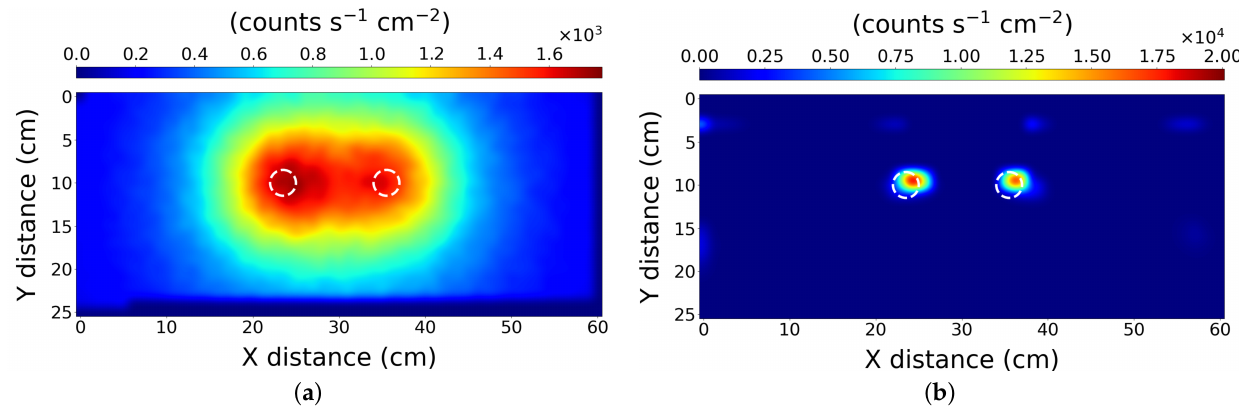
Figure 5. The results from scenario 3—Proximity limit. After processing with ( a ) simple interpolation, and ( b ) the PLR algorithm. The scan used a 1 cm resolution. The dashed white circles represent the true location of the source